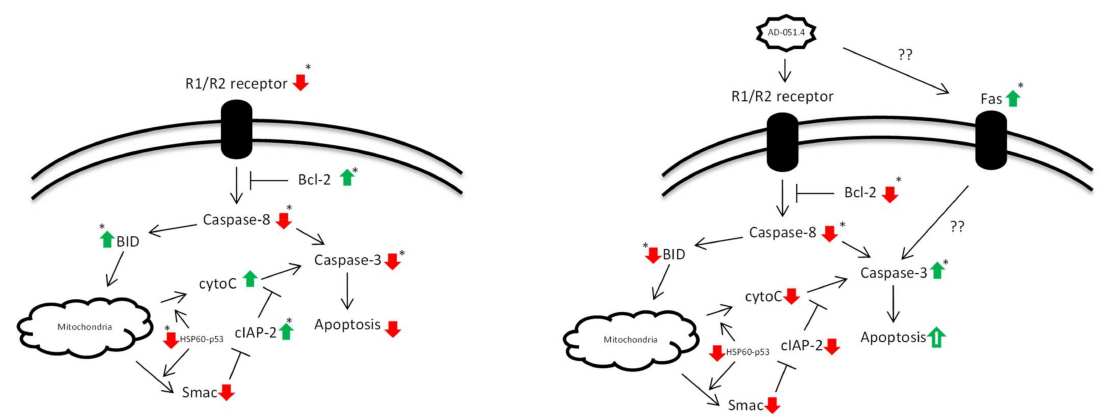
Figure 8. A possible explanation for the extra- and intracellular origins of resistance to AD-O51.4 and TRAIL in SW480 cells. Simplified figure showing the propagation of apoptosis signals within cells. Arrows indicate the increased/decreased expression of specific proteins observed after acquisition of resistance, *—abundance significantly altered ( p < 0.05) as shown on Figure 5. Left panel: decreased abundance of R1 and R2 surface receptors together with an increased level of Bcl-2 result in a decreased level of Caspase-8 further decreasing Caspase-3 abundance undermining apoptosis. In addition, the decreased abundance of HSP60-p53 complex and increased abundance of cIAP-2 are observed, which suggests inhibition of mitochondrial apoptotic pathway. The same protein alterations were observed by Rozga et al. [28]. Right panel: addition of AD-O54.1 evokes low apoptosis response. Despite an decreased abundance of Caspase-8, increased abundance of Caspase-3 is observed leading to weak apoptosis signal propagation. The Caspase-8-independent Caspase-3 activation could be explained with the observed Fas and FasL increase, furthermore, low BIDlevels preclude mitochondrial pathway involvement in Caspase-3